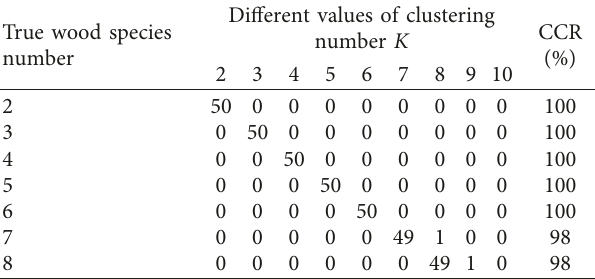
Table 4: CFSFDP clustering analysis with CH criterion.